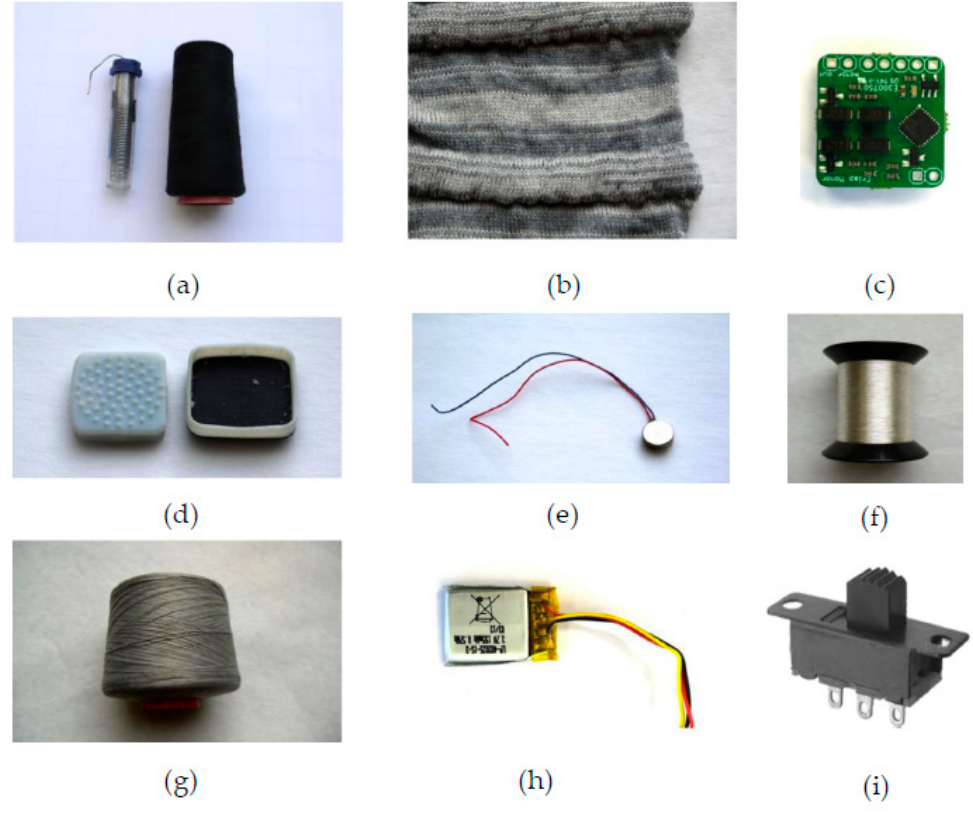
Figure 1. Textile and electronic materials used in e-textiles. ( a ) Solder and polyester thread used into e-textiles; ( b ) E-textile capacitor; ( c ) Printed Circuit Board (PCB) for e-textiles; ( d ) Casing shell for e-textiles; ( e ) Vibration motor; ( f ) Elektrisola textile conductive wire; ( g ) Bekintex conductive thread; ( h ) Lithium-ion battery used to power e-textiles; and, ( i ) Slide switch used to switch On/Off e-textiles [25].